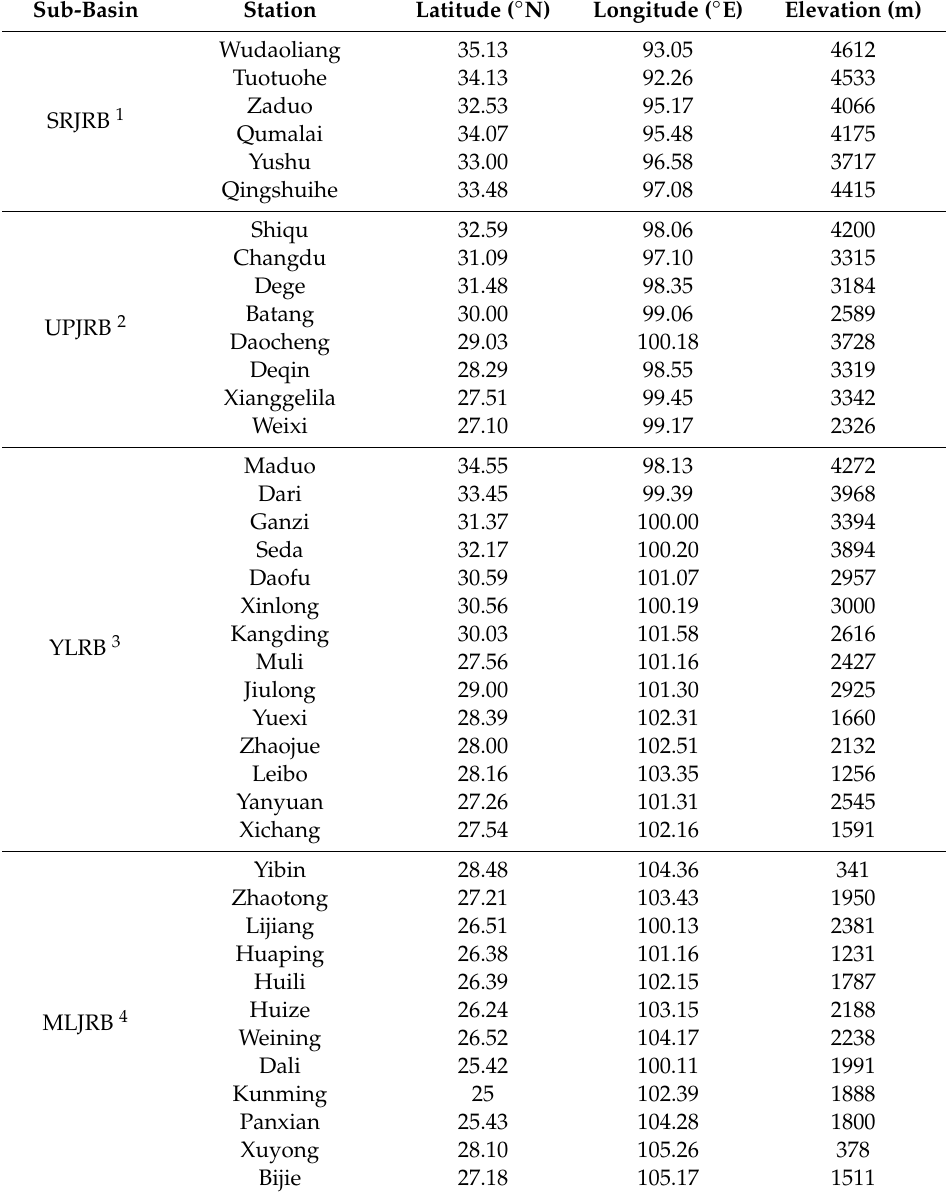
Table 1. Geographical information of weather stations in the Jinsha River Basin.